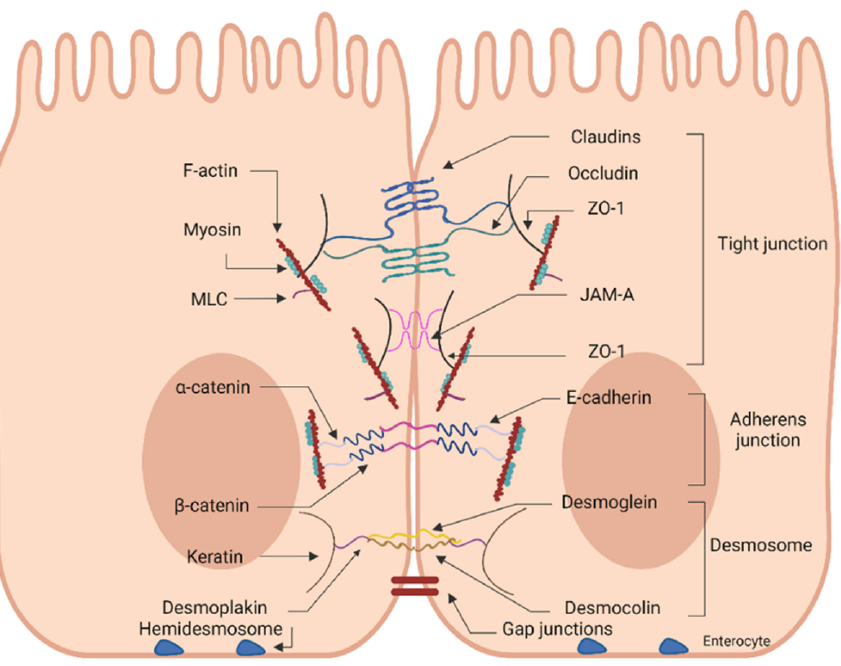
Figure 1. Junctional complex of IECs from apical to basal: TJs (ZO-1, -2, -3, occludin, claudins, JAM-A/1, -B/2, -C/3) serve as the principal paracellular barrier. AJs (cadherin-1, -2, α -, β -, γ -, δ -catenins) form the adhesion belt and hold together adjacent cells. TJs and AJs interact with F-actin to form the apical junctional complex. Desmosomes (desmoglein, desmocollin, desmoplakin, keratin) are “buttonlike” points of intercellular contact fixing cells together. Gap junctions (connexins) serve in cell–cell communication. Created with BioRender.com. AJ, Adherens junctions; IECS, Intestinal epithelial cells; TJ, Tight junctions.